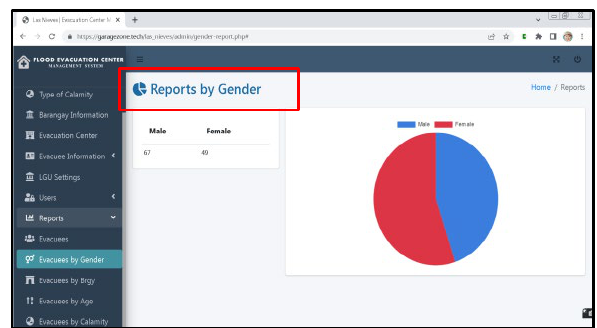
Figure 25. Reports of Evacuees by